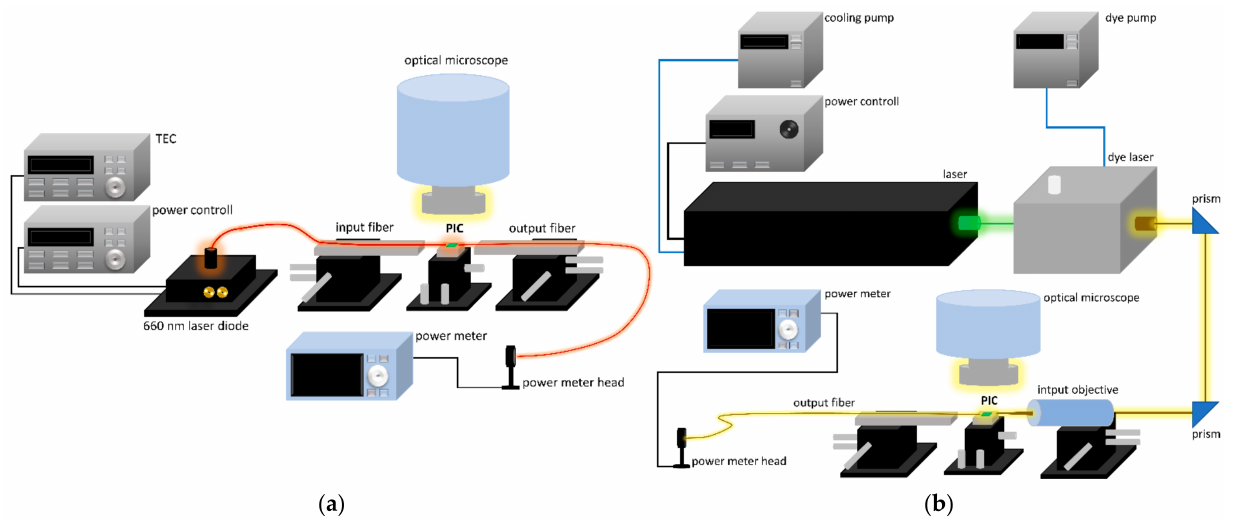
Figure 13. Characterization setups schematics: ( a ) setup utilized for characterization of waveguides (WGs) and MMIs; ( b ) setup utilized for AWGs